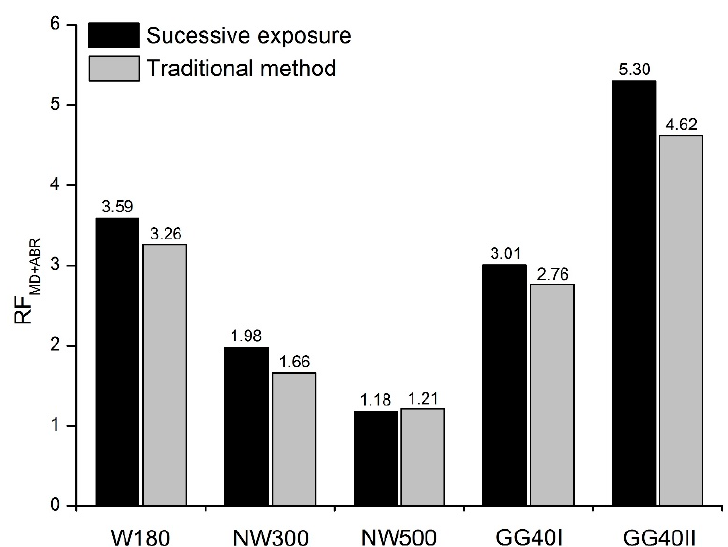
Figure 7. Comparison between the RF MD + ABR found in the successive exposure to mechanical damage under repeated loading and abrasion with those obtained by the traditional method for the combined effect of both degradation mechanisms.